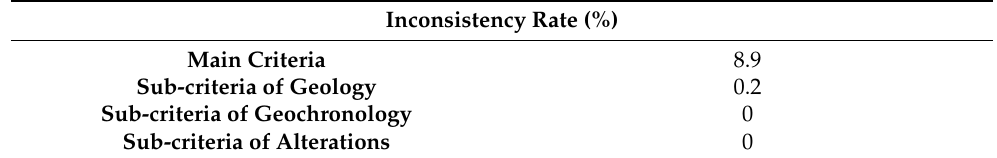
Table 12. The inconsistency rate (%) of criteria and sub-criteria paired comparison